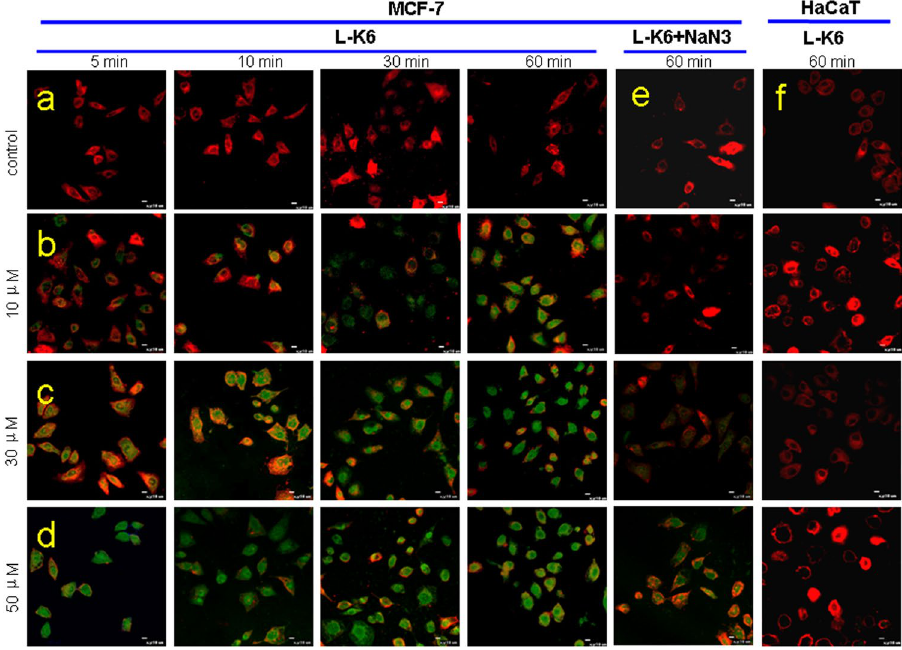
Figure 4. L-K6 specifically enters MCF-7 cells in a dose-dependent manner. At the beginning of the observation, lower concentrations (10 μ M) FITC-labeled L-K6 initially accumulated around the tumor cell membranes. However, with increasing peptide concentrations and incubation times, the location of the FITC- labeled L-K6 was transferred into the cytoplasm, as indicated by the increased intracellular green fluorescence intensity ( a – d ). Moreover, pre-incubation of MCF-7 cells with NaN 3 blocked the uptake of L-K6 ( e ). In contrast to MCF-7 cells, HaCaT cells displayed negligible cellular uptake levels of L-K6 even after 60 min exposure ( f ).